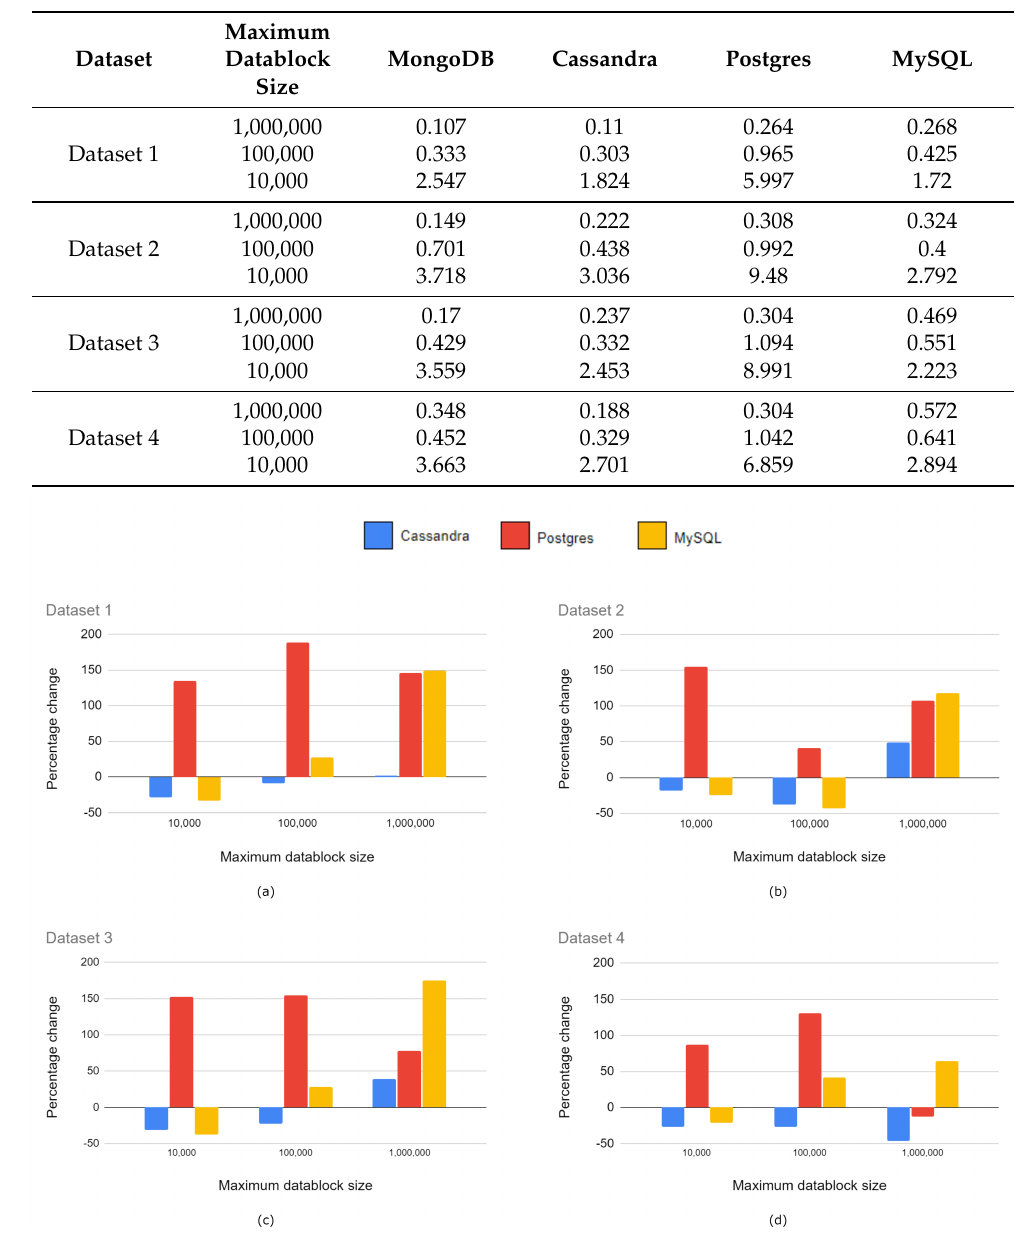
Table 4. Average times (in seconds) of a request operation of 1M points in the implementations based on MongoDB, Cassandra, PostgreSQL and MySQL.